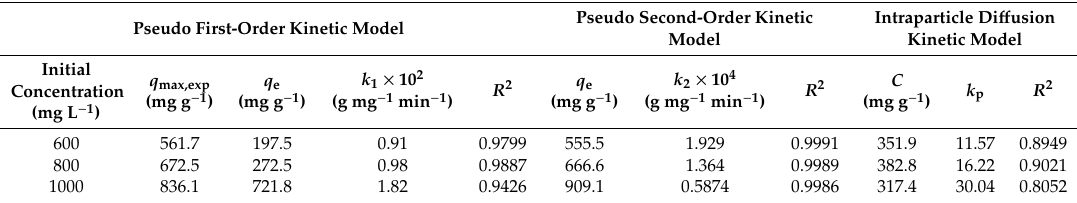
Table 2. DCFS enrichment kinetic parameters at 318.15 K (initial pH 8.0).